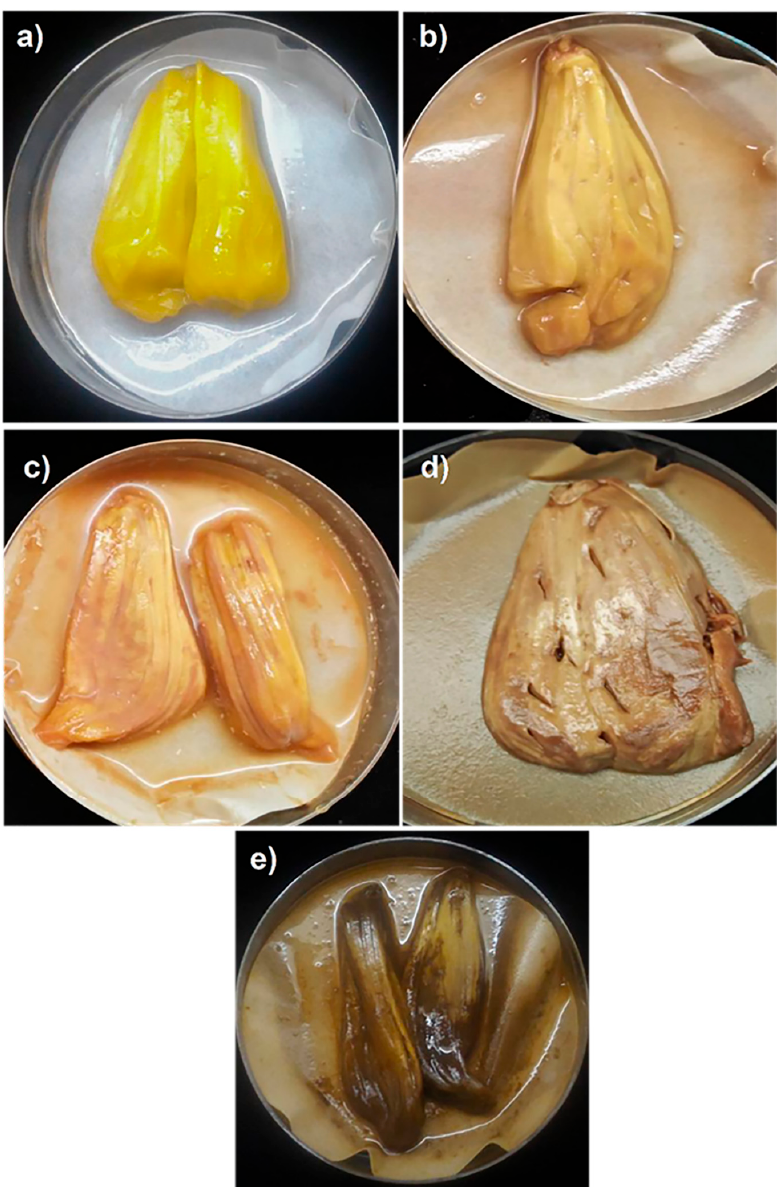
Figure 1. The disease rating of the reddish discoloration of jackfruit pulps (rating 0–4). ( a ) Disease rating 0; ( b ) disease rating 1; ( c ) disease rating 2; ( d ) disease rating 3; ( e ) disease rating 4.